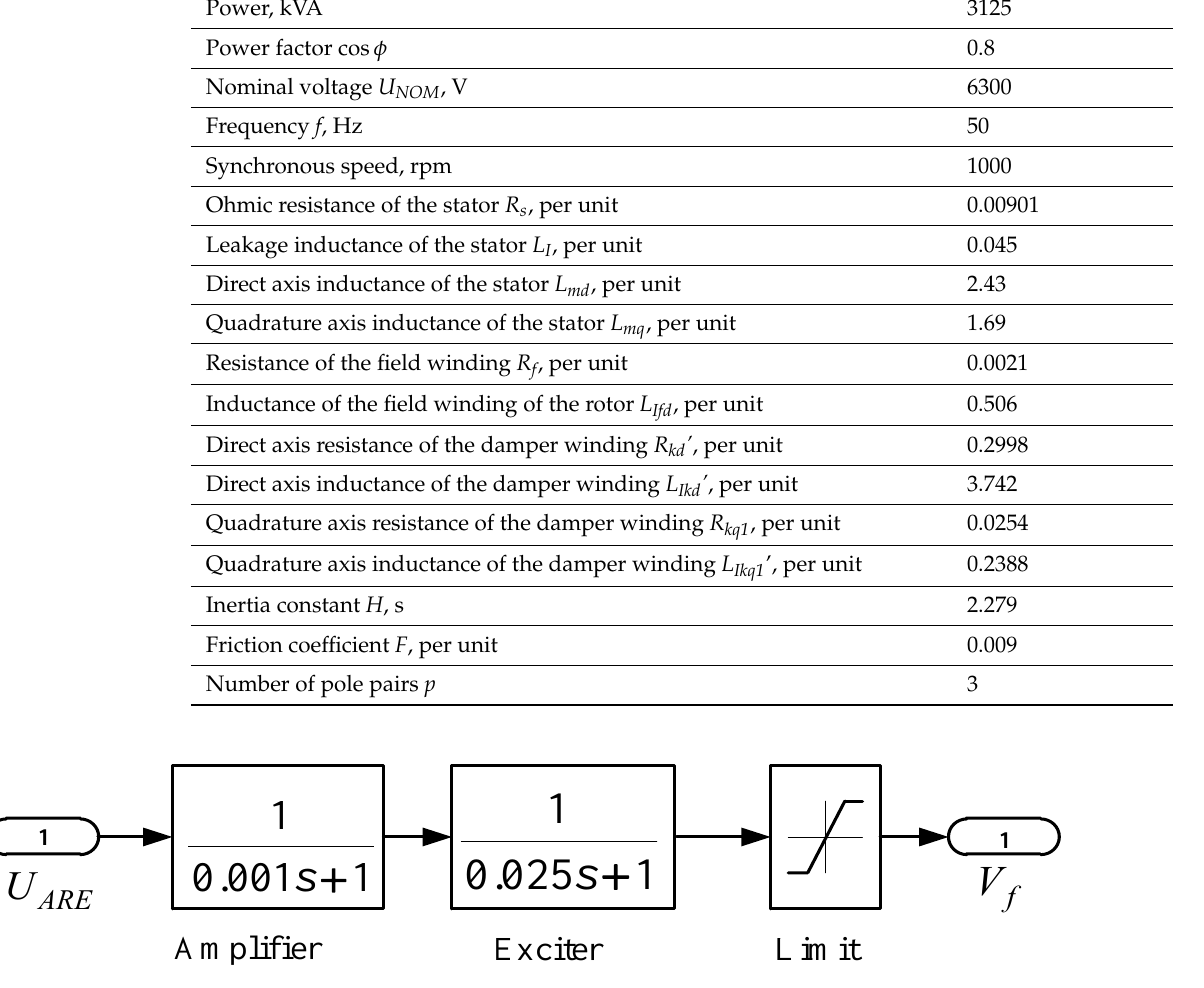
Figure 2. Block diagram of the thyristor excitation system model in MATLAB: U ARE — signal coming from ARE; V f — signal coming to generator field winding; limit — voltage limitation block.